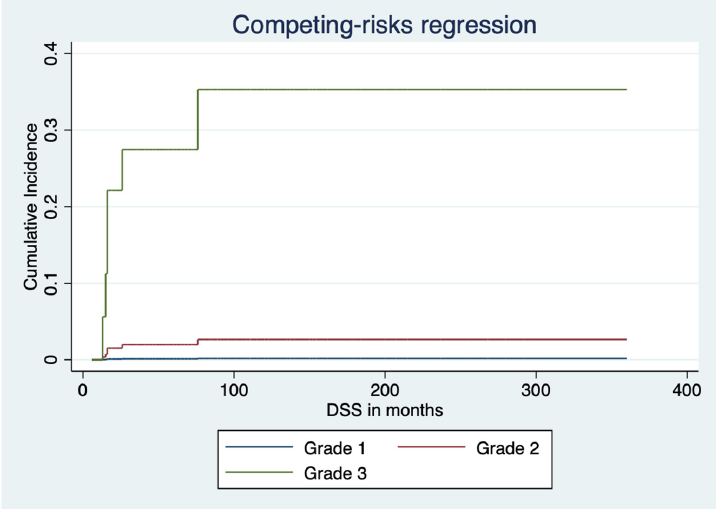
Figure 3. The role of grade in disease speci fi c failure studied with a competing risk model.